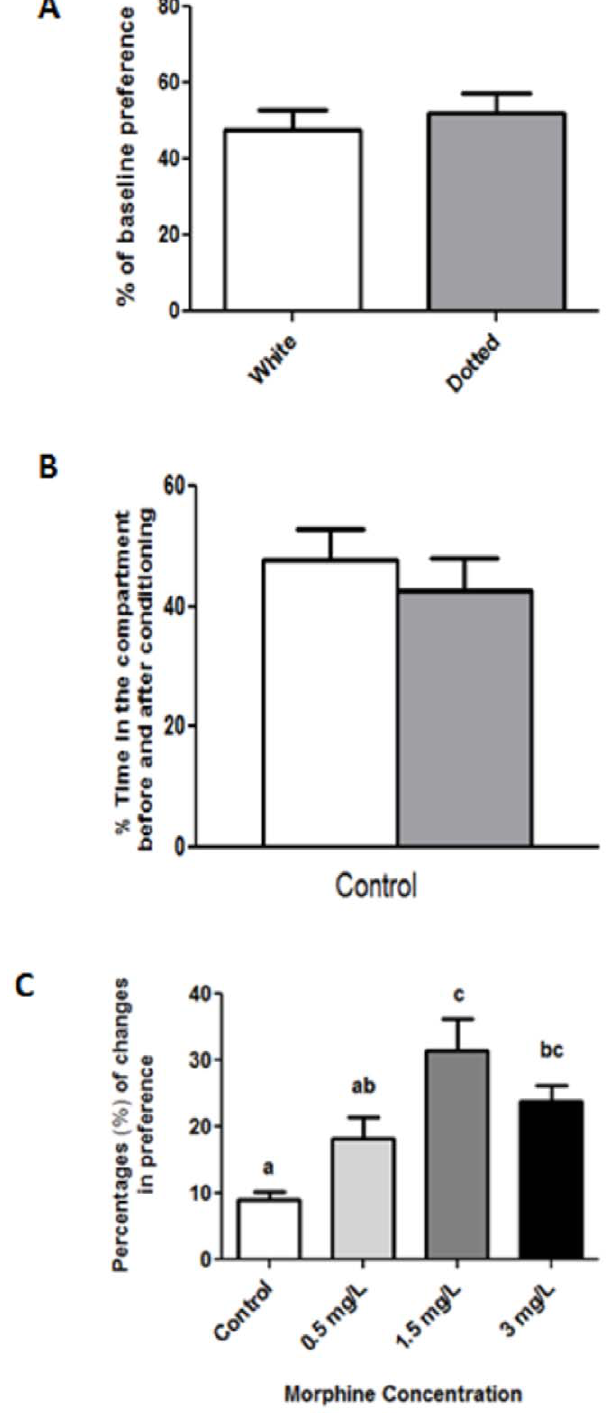
Figure 1. Conditioned Place Preference (CPP) test for morphine in adult zebrafish. (A) Baseline preference of fish between dotted vs. white compartment as shown by percentage of initial time spend in compartment (n=23). (B) Preference behavior responses in the CPP tanks for control group as shown by percentage of time spent in conditioning compartment before (white bar) and after (grey bar) conditioning. (n=15). (C) Place preference behavior of adult zebrafish treated different morphine concentration (Control, n=15; 0.5 mg/L, n=18; 1.5 mg/L, n=16; 3 mg/L, n=15). Mean values were subjected